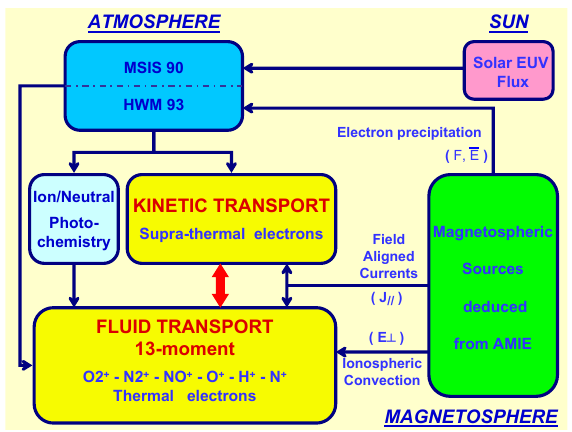
Fig. 1. Synopsis of the TRANSCAR model showing the coupling between the fluid model for the thermal plasma and the kinetic model for the supra-thermal electrons. Inputs from MSIS-90 and HWM-93 neutral atmosphere models and AMIE computations are also